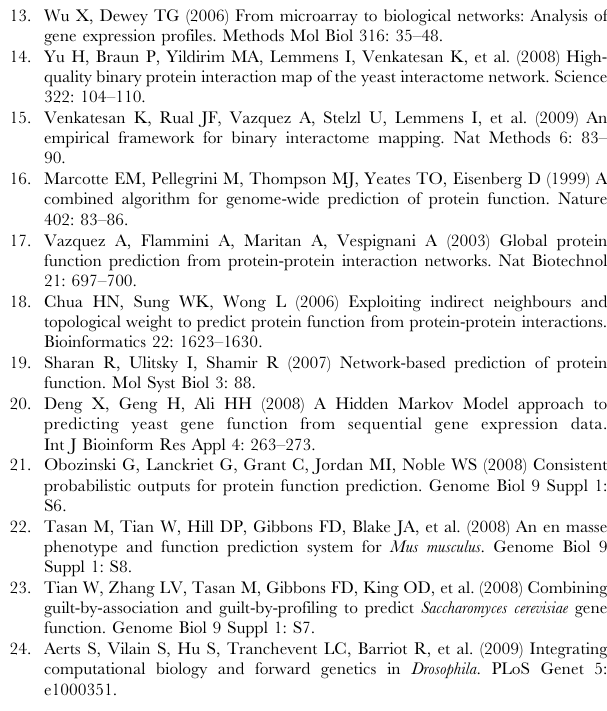
Table S6 Keyword matching between RNAi screens and gene functions. Table S7 Additional Expression Profiles from NCBI Gene Expression Omnibus (GEO). Figure S1 Genetic interaction profiles. A, Both pathway P1 and P2 drive downstream processes to achieve a function; loss of genes within either pathway will not abolish the function. However, when a pair of genes from the two pathways respectively are lost (e.g. a-x, a-y, c-x), both pathways will be broken and a loss-of- function phenotype will emerge. B, Genes within the same pathway have similar genetic interaction profiles, which could be useful in categorizing a,b,c and x,y,z into pathway P1 and P2 respectively. Figure S2 Code performance of Functional-Specific Classifier model and canonical supervised machine-learning model. Figure S3 Performance of GO prediction when removing one feature at a time from the model. Receiver Operating Character- istic curves (A) and Precision-Recall curves (B) for the overall performance and the performance when removing one feature at a time in GO term (biological process, BP) prediction. Precision- Recall curves for the GO term prediction model for GO terms with various degrees of specificity, i.e., those that have been annotated with 0–25 genes (C), 25–50 genes (D), 50–100 genes (E), and 100–500 genes (F). Figure S4 Performance of KEGG prediction when removing one feature at a time from the model. Receiver Operating